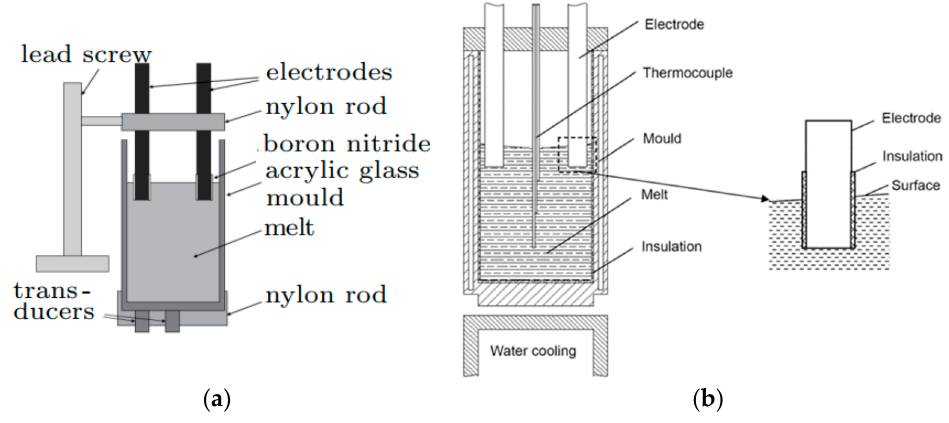
Figure 2. Schematic drawing of the experimental setup: ( a ) [1]; and ( b ) [2]. A fundamentally different scheme for processing the ECP melt is given in [4] (Figure 3).